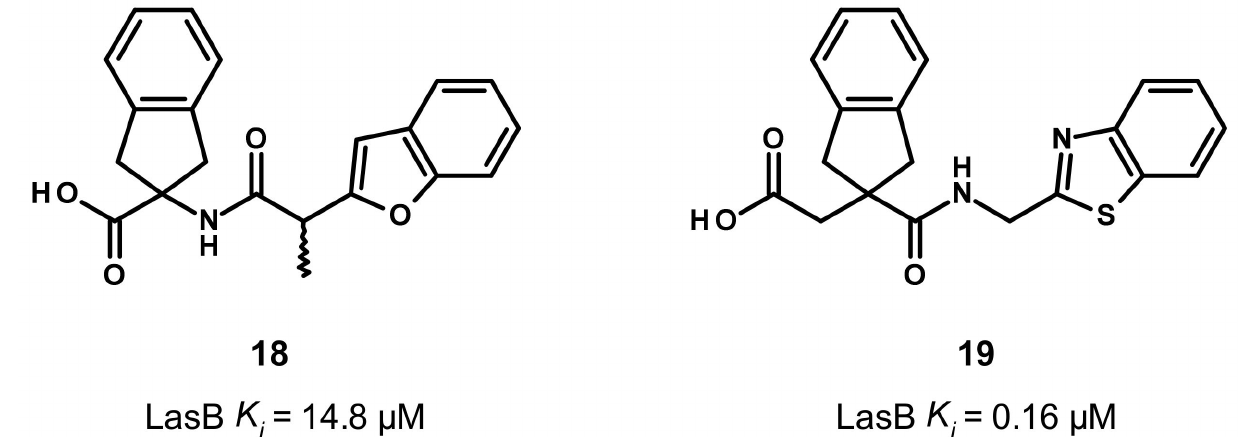
Figure 11. Chemical structures and biochemical activities of the carboxylic acid compounds 18 and 19 . K i values were extracted from the original publication